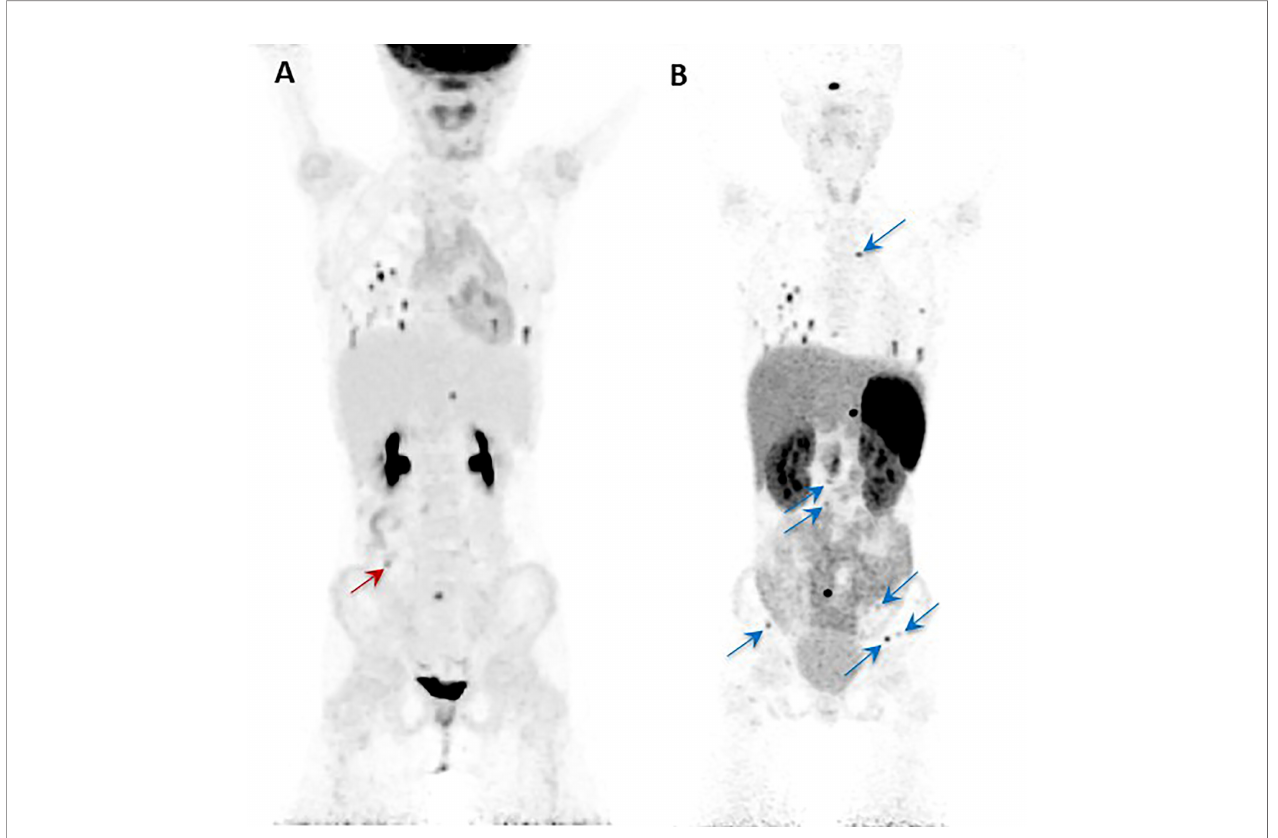
FIGURE 2 | Anterior maximal intensity projection (MIP) images of the 18 F-FDG PET/CT (A) and 68 Ga-DOTATATE PET/CT (B) studies of a 10-year-old SDHB positive girl. She was diagnosed initially with metastatic disease at the age of 8 years. Her right paraaortic, retroperitoneal primary paraganglioma was surgically resected. On presentation to our institution, the progression of her disease was demonstrated by metastatic lesions in bone, lungs, and abdomen as shown in the images (A, B) . The single red arrow on image (A) indicates the one lesion (abutting bowel) localized by 18 F-FDG PET/CT that is not visualized by the 68 Ga-DOTATATE PET/CT. Similarly, all the additional lesions (transverse process of T4 spine, L2-L5 vertebral bodies, left ilium, and left and right iliac wings) localized by the 68 Ga-DOTATATE PET/CT (blue arrows) are not visualized by 18 F-FDG PET/CT (B) . This fi gure was adapted from the fi gure that was initially published as Figure 2 by Jha et al.